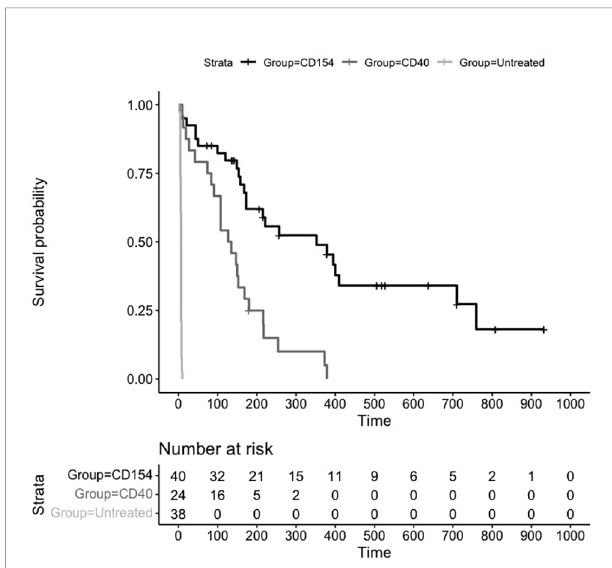
FIGURE 2 | Kaplan Meier Survival Plot and Risk Table for Treatments versus Placebo. Kaplan-Meier estimates of the probability of rejection free survival by treatment group. Median survival untreated (6 days), CD40 (131 days), and CD154 (352 days) groups (P = 0.0001; log-rank